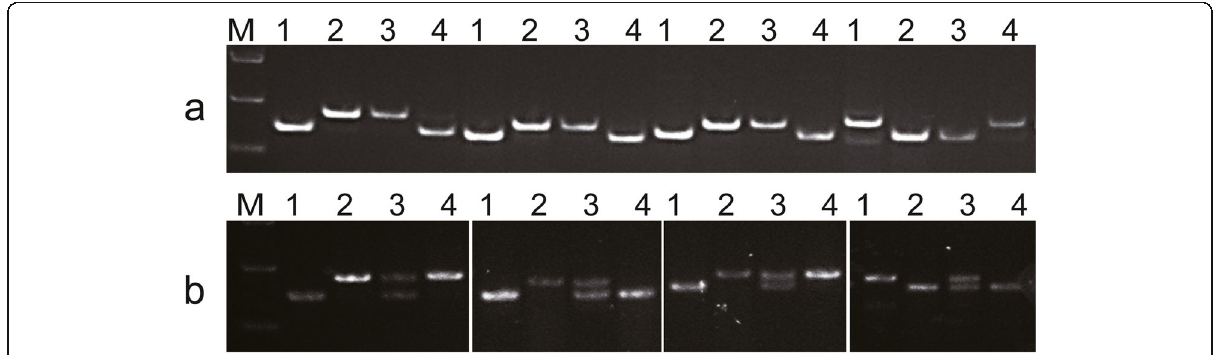
Fig. 2 Amplification results of ‘ Nanjing 46 ’ , ‘ Zhaxima ’ , F1 hybrids, and regeneration plants using indel primer (R3M23, R4M17, R4M43, and R5M30). In row “ a ” , lane 1 is Nipponbare, lane 2 is Nanjing 16, lane 3 is Zhaxima, and lane 4 is Nanjing 46. In row “ b ” , lane 1 is Nipponbare, lane 2 is Nanjing 16, lane 3 is the F1 hybrid, and lane 4 is the regenerated